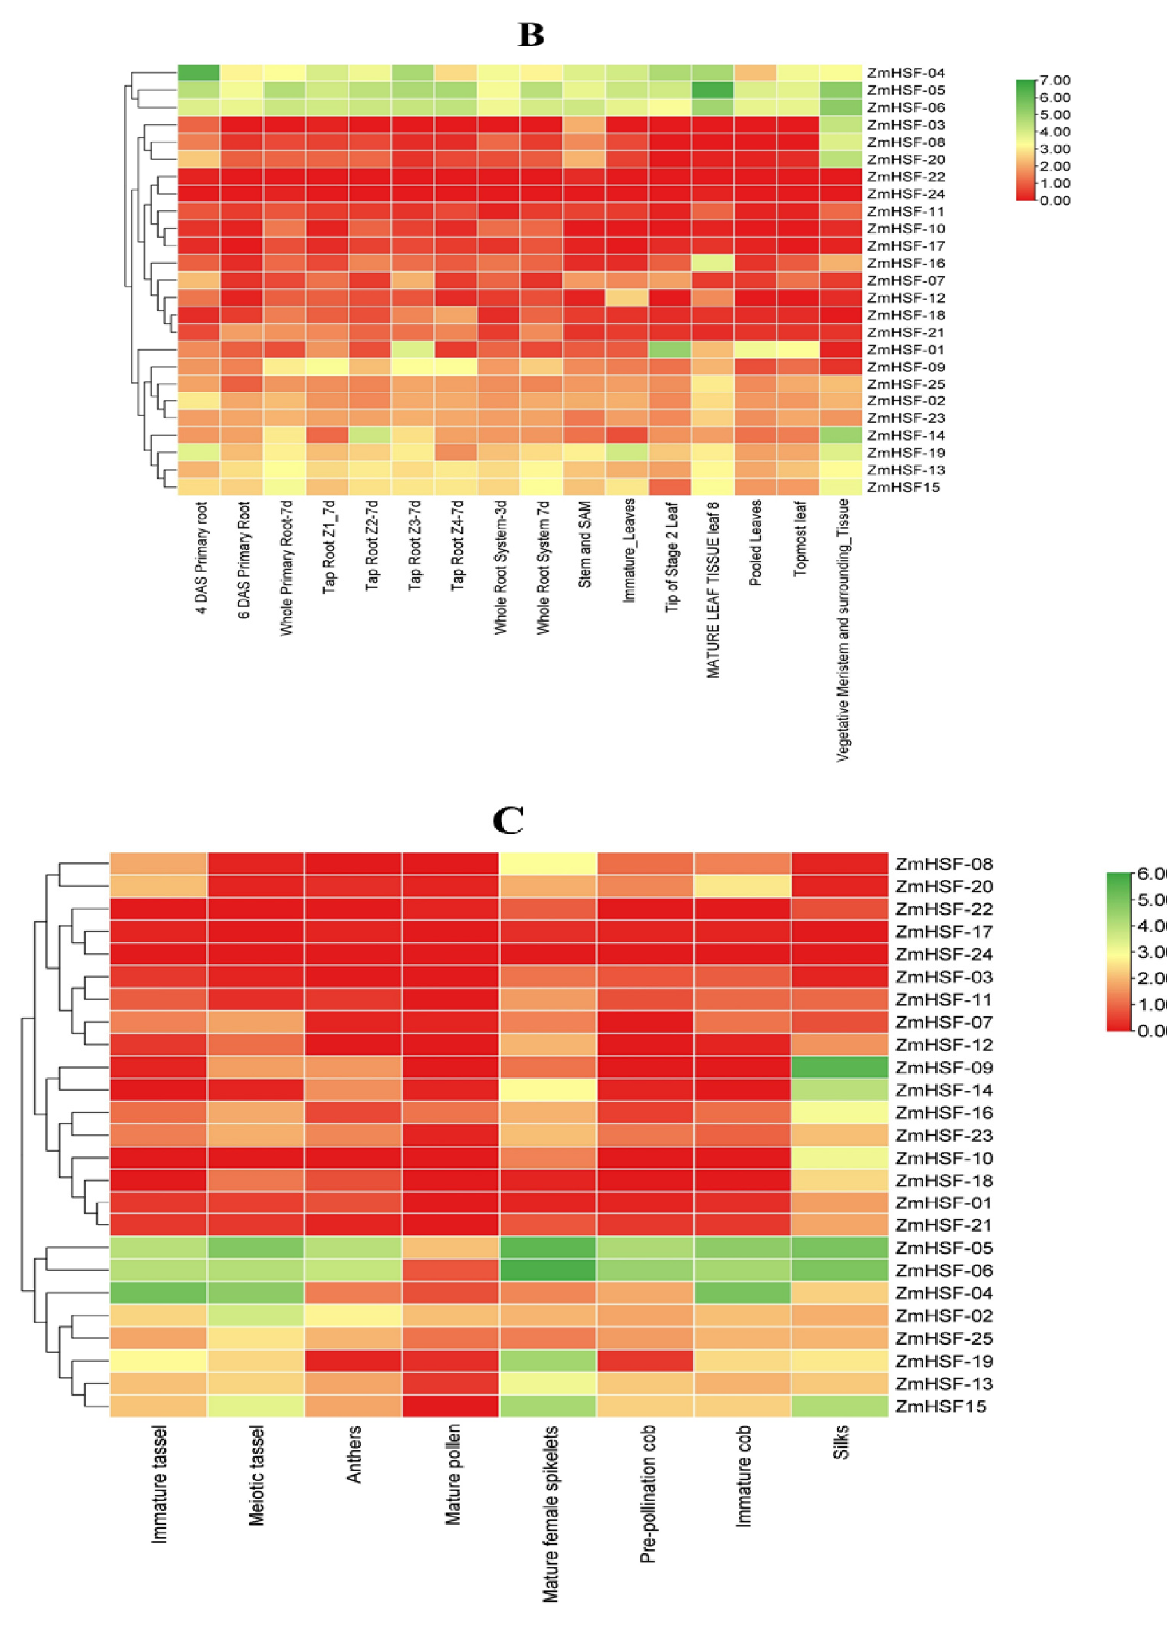
Figure 9. Expression profiles of maize HSFs in different seed ( A ), vegetative ( B ), and reproductive ( C ) tissues based on transcriptome data. The heat map was constructed using Tbtools. The color bar at the top right represents the log transformed FPKM values. Green represents higher, red lower, and yellow, medium transcript